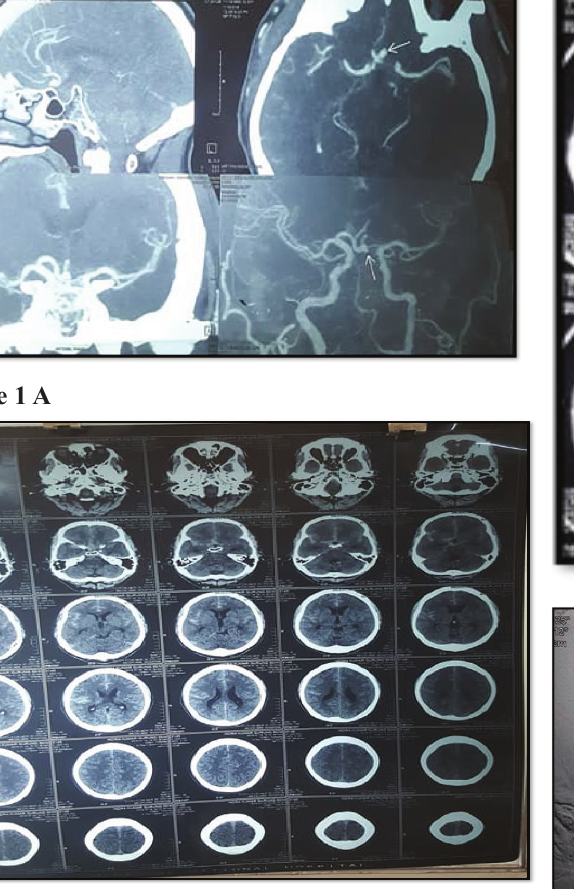
Figure 1. 50-year male with WFNS 1 who underwent clipping on 4 th day of ictus. A: Plain CT head showing diffuse SAH. B: CT angiogram showed ACom aneurysm.